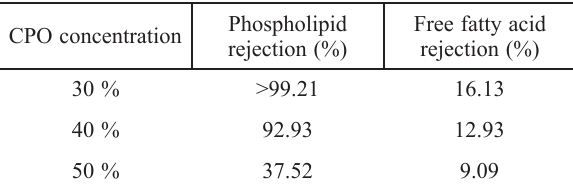
Table 3 – Rejection of phospholipid and fatty acids at vari- ous CPO concentrations at a pressure of 1 bar and feed tem-